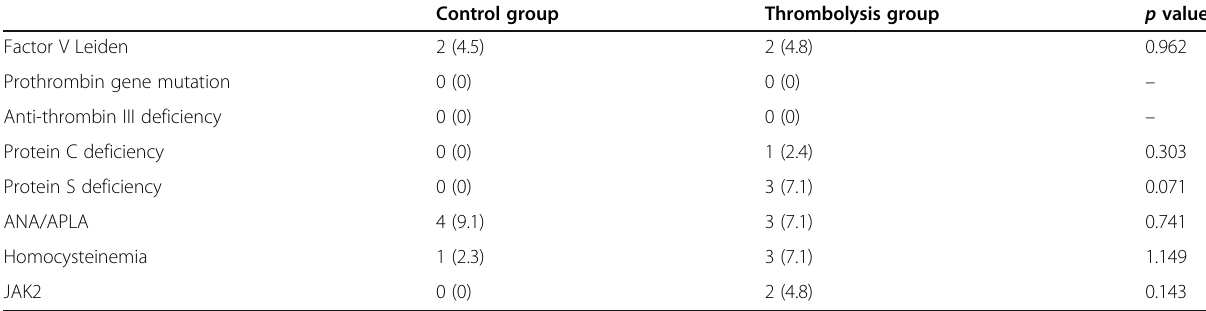
Table 2 Etiological (inherited) profile of the study group Control group Thrombolysis